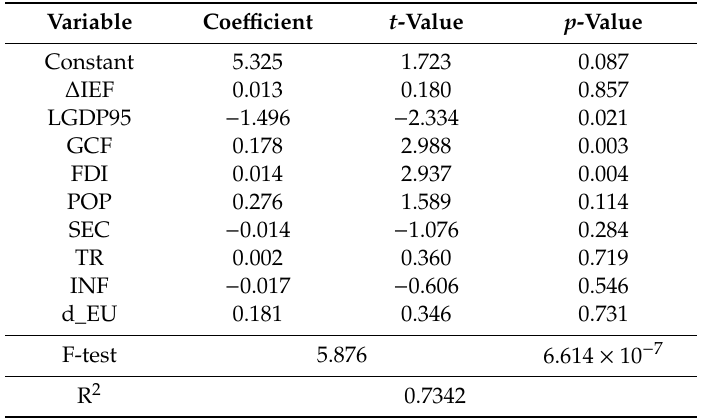
Table 8. Results from the LSDV model with change of economic freedom index ( ∆